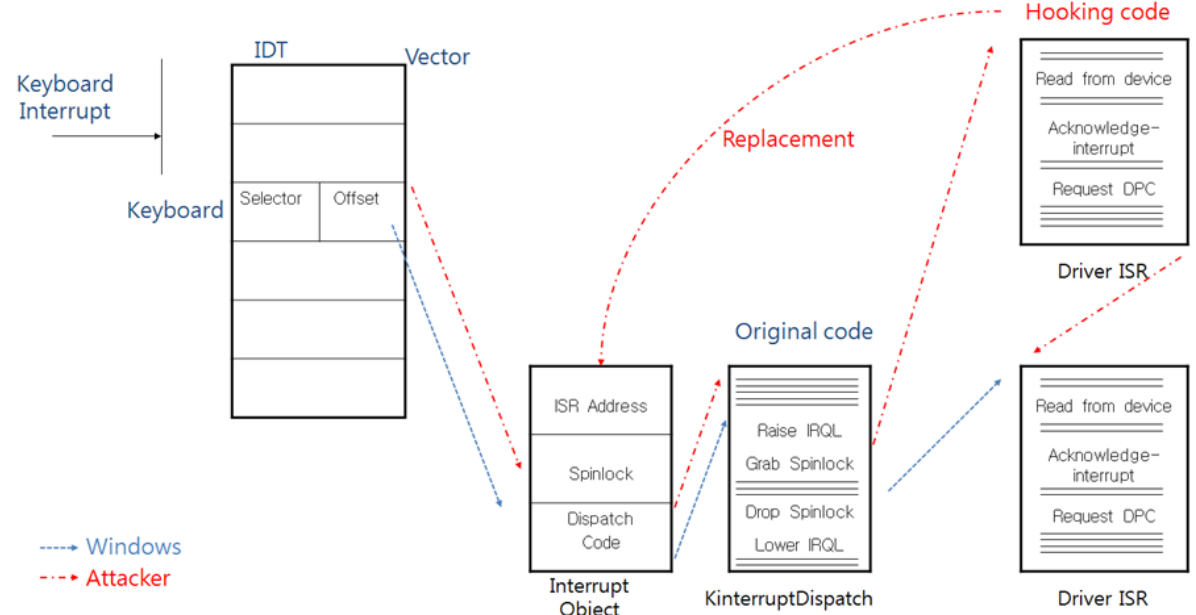
Figure 4. The calling process after the ISR is replaced by the attacker.